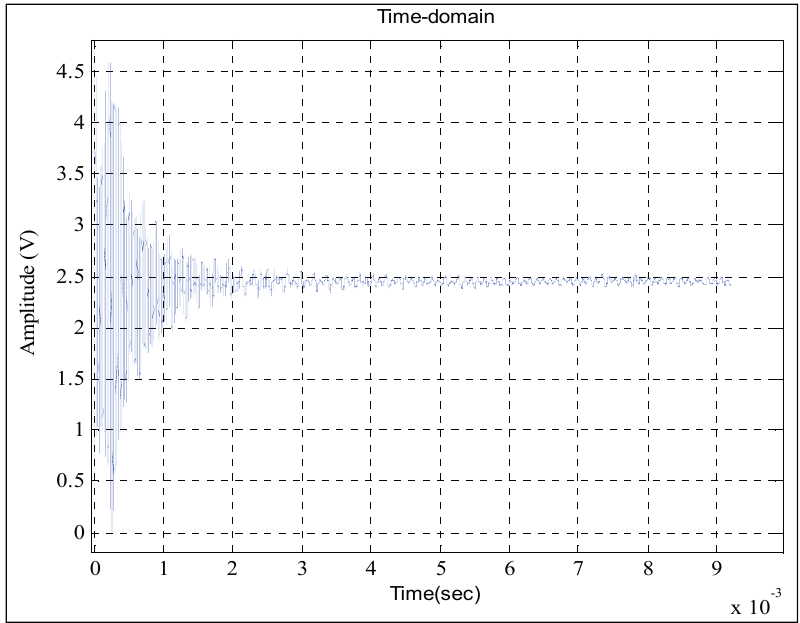
Figure 6. Output signal of the calibrated pressure sensor in the shock tube